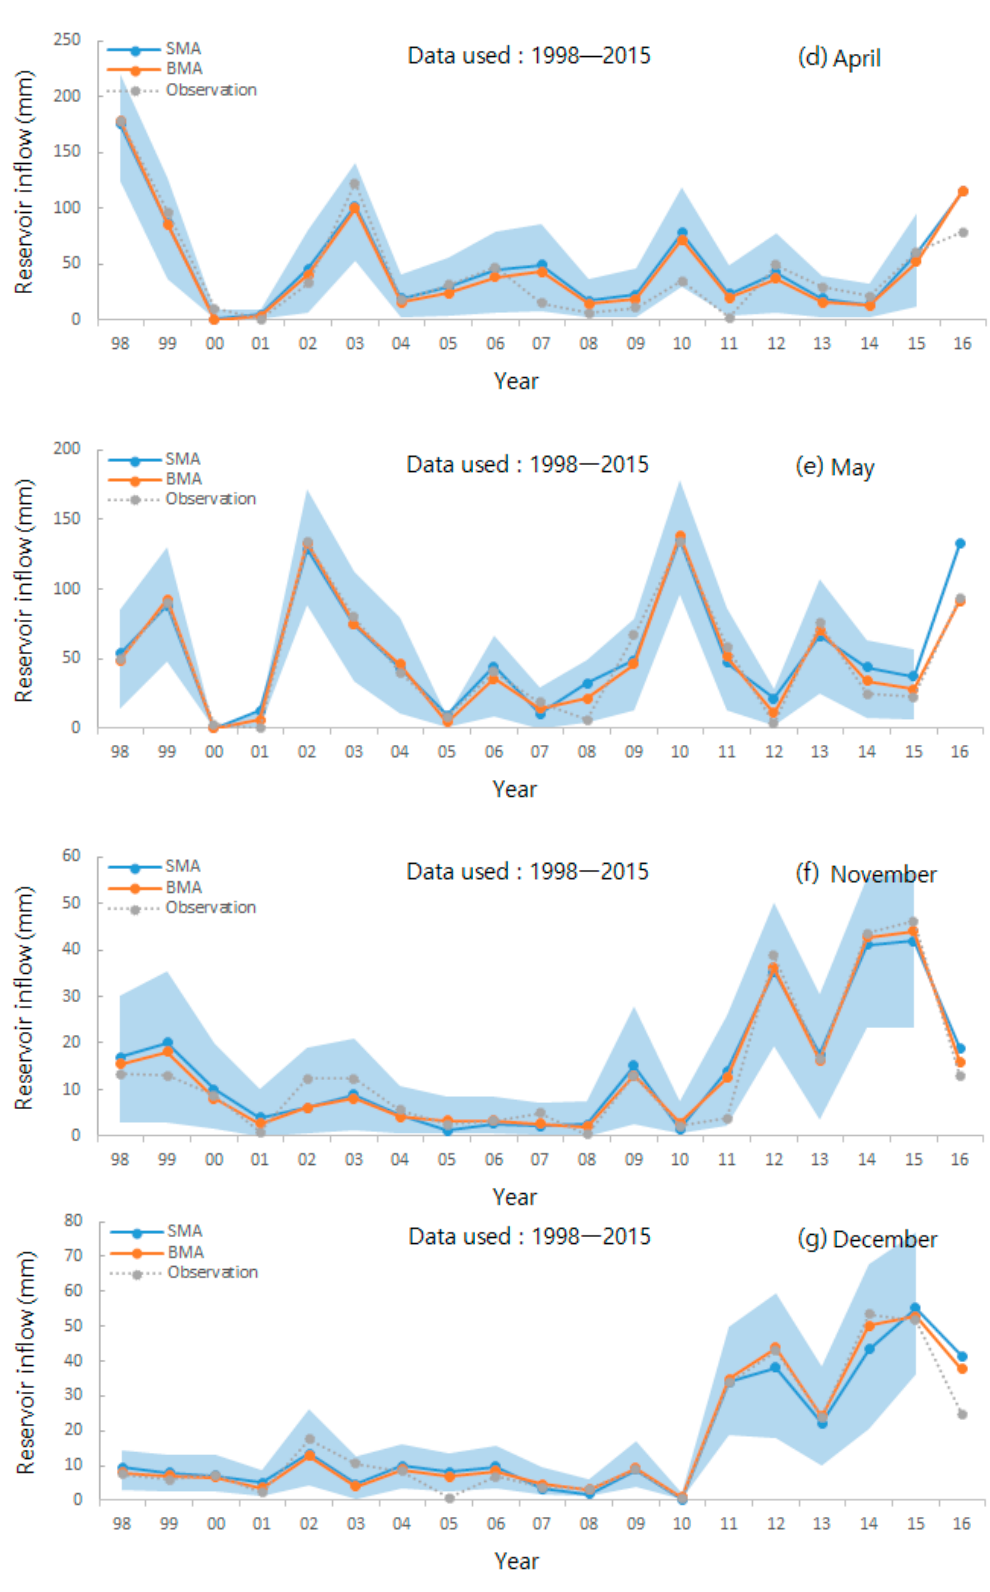
Figure 7. Comparison of forecasts between SMA and BMA for January ( a ), February ( b ), March ( c ), April ( d ), May ( e ), November ( f ) and December ( g ) of target year 2016. The red line displays the mean point forecast of the BMA method, whereas the block dots are observations. Grey region indicates 95% prediction interval.